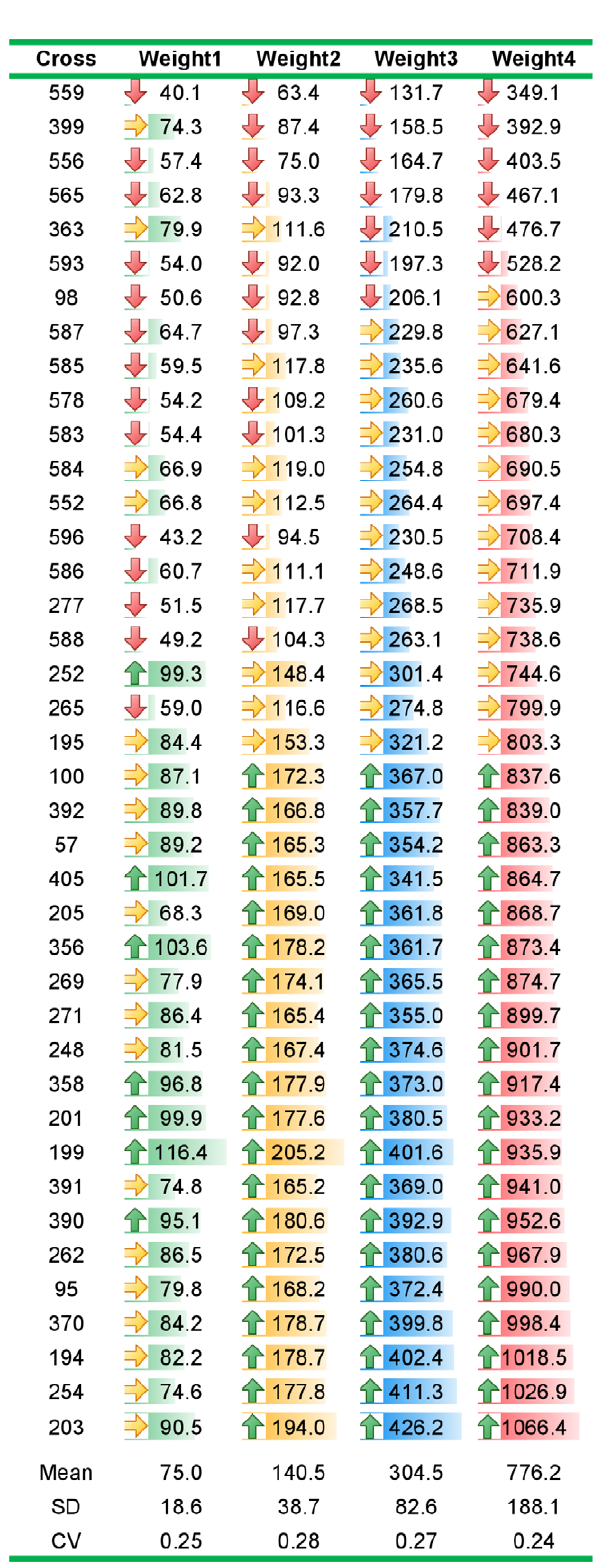
Figure 2. Variation in average family body weight (BW) measured in grams at approximately 6, 7, 9 and 12 months post-hatching (Weight1, Weight2, Weight3 and Weight4). CV (SD/mean) indicates the phenotypic coefficients of variation. Color intensities (green, blue and red) reflect changes in mean of BWs of